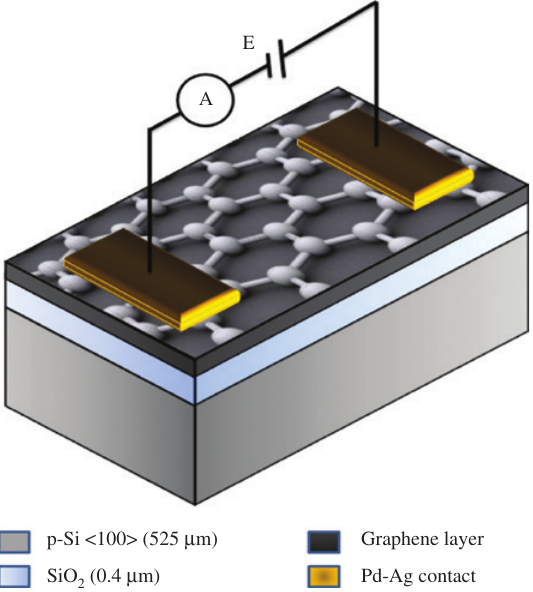
Figure 4: Schematic of the